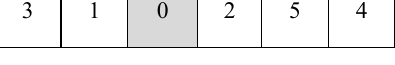
Fig. 3. Solution representation